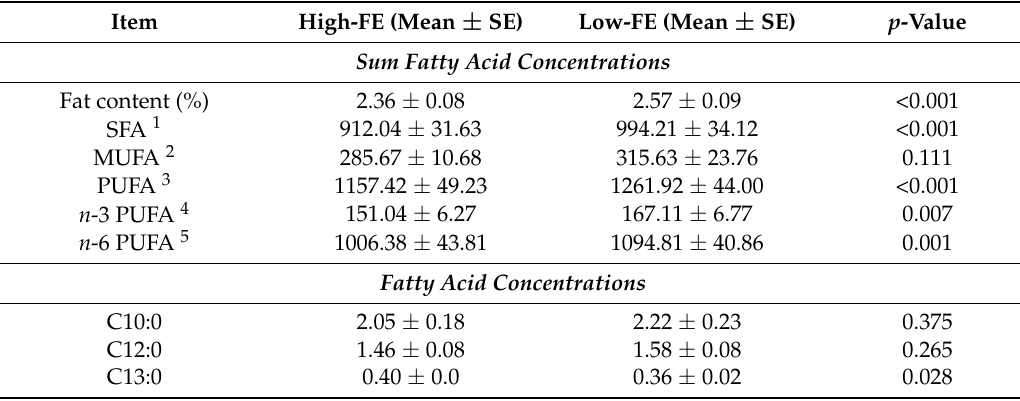
Table 2. Fatty acid content in liver tissue obtained from animals divergent in feed efficiency (FE; measured by residual feed intake) at day 140 of life ( n = 24). Values are displayed as mg/100 g